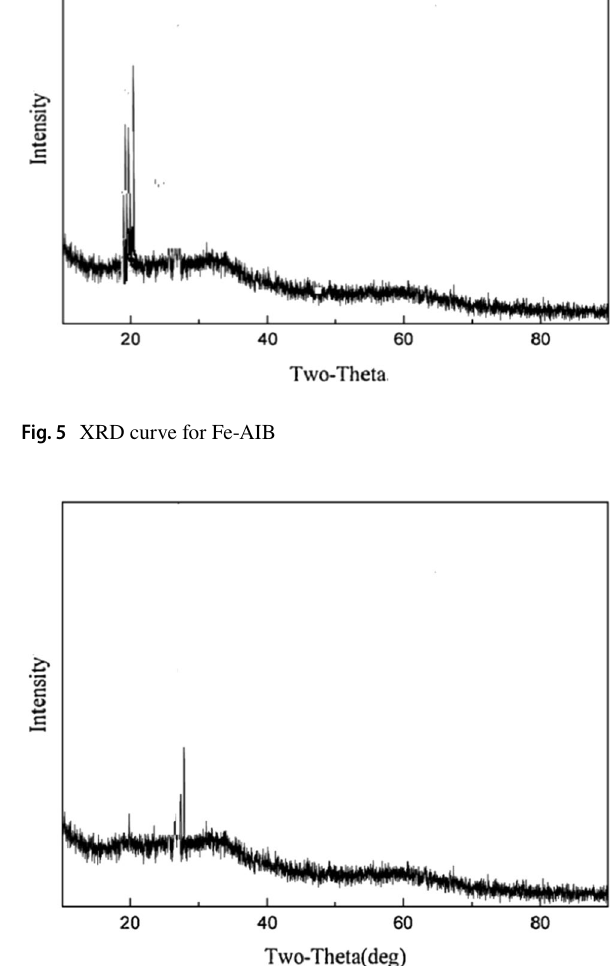
Fig. 4 EDX image and elemental composition Fe-AI